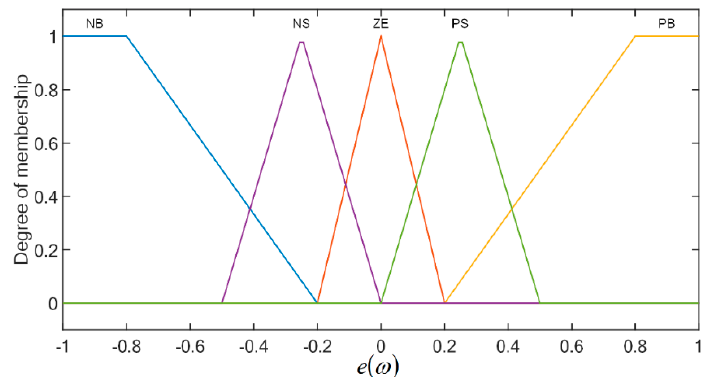
Figure 12. Membership function of 𝑒(𝜔) .